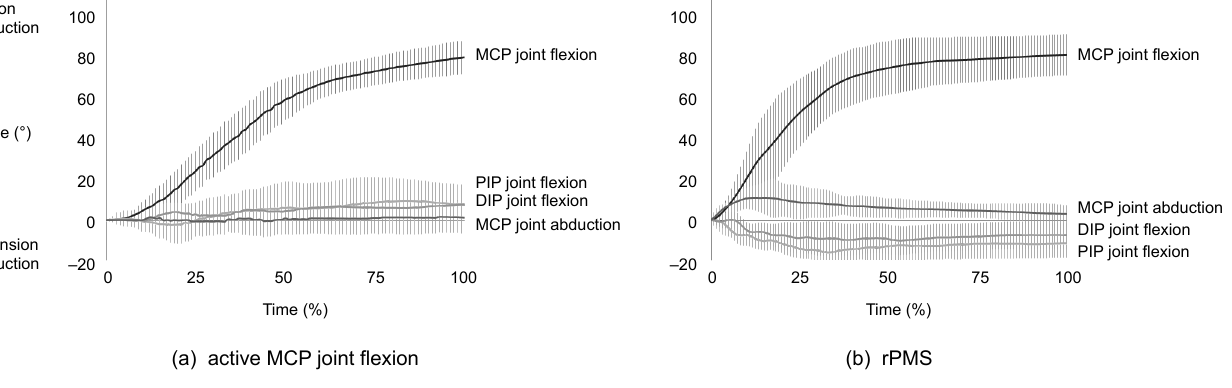
Figure 2. Temporal changes in the MCP, PIP, and DIP joint angles of the index finger during active MCP joint flexion and rPMS. The solid lines represent the average changes in joint angles of the index finger, while the vertical lines represent the SD. ( a ) The PIP and DIP joints were slightly flexed with MCP joint flexion in active MCP joint flexion. ( b ) The MCP joint abducted and flexed shortly after the onset of rPMS, and the flexion angle increased as the abduction angle of the MCP joint decreased. The PIP and DIP joints